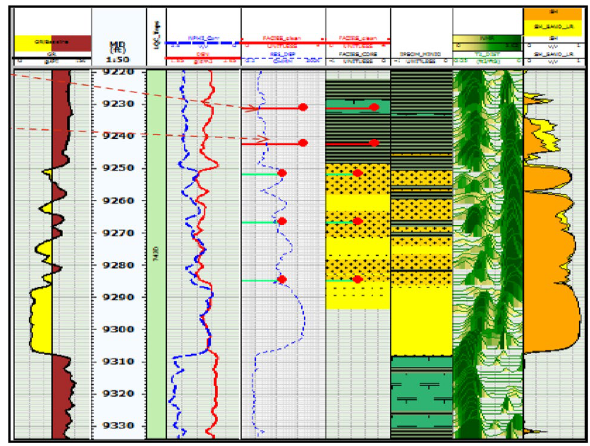
Fig. 1 Capillary behaviors and log responses of the channel storey axis (CSA), margins (CSM), and inter-channel thin beds-deep water